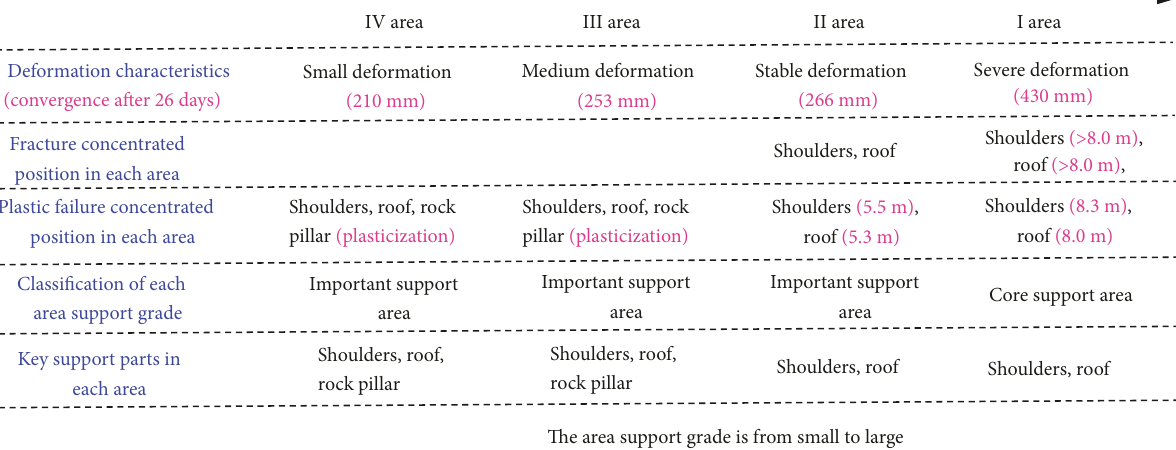
Figure 7: Division of maintenance control area and determination of key support